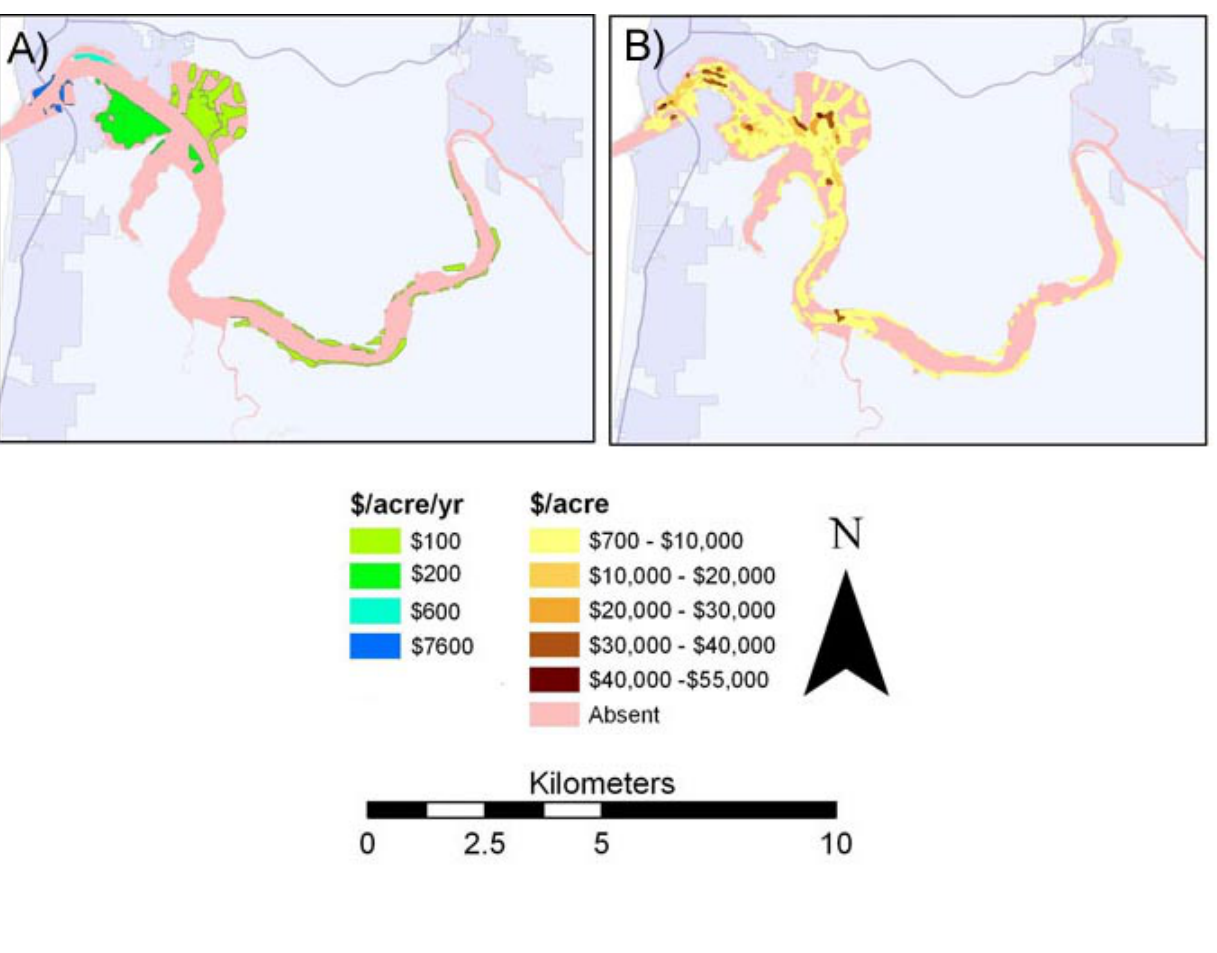
Fig. 3. (A) Current distribution of recreational clam-digging value (Oregon Department of Fish and Wildlife, unpublished data ). (B) Distribution of clam density and potential exploitation (adapted from Hancock et al.